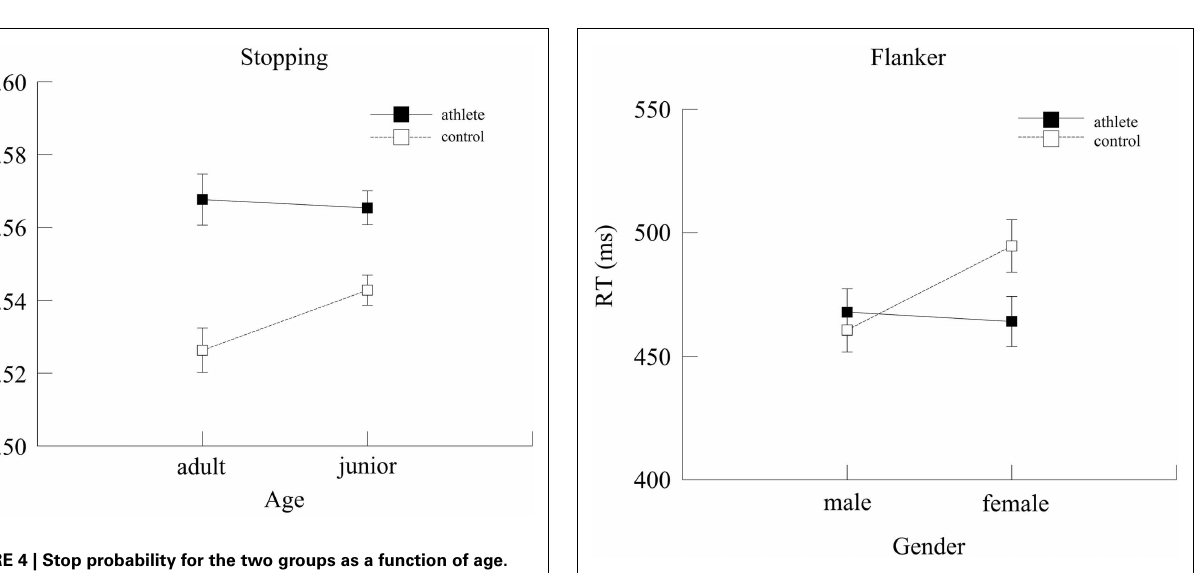
FIGURE 5 | Mean reaction time (ms) for the two groups as a function of gender. Error bars represent ± 1 standard error.